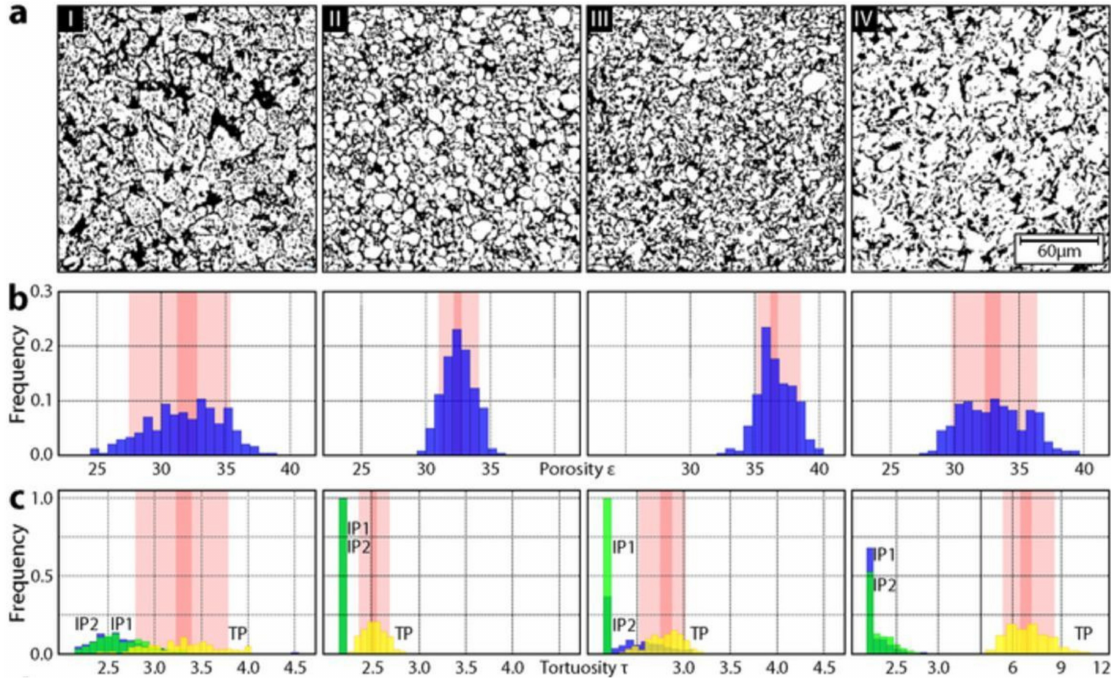
Figure 2. Tomogram results of one sample of four different negative electrodes revealing: ( a ) the types of graphite particles with associated ( b ) porosity and ( c ) tortuosity. IP1 and IP2 correspond to two in-plane directions while TP corresponds to the through-plane direction (modified from CC BY Müller et al.